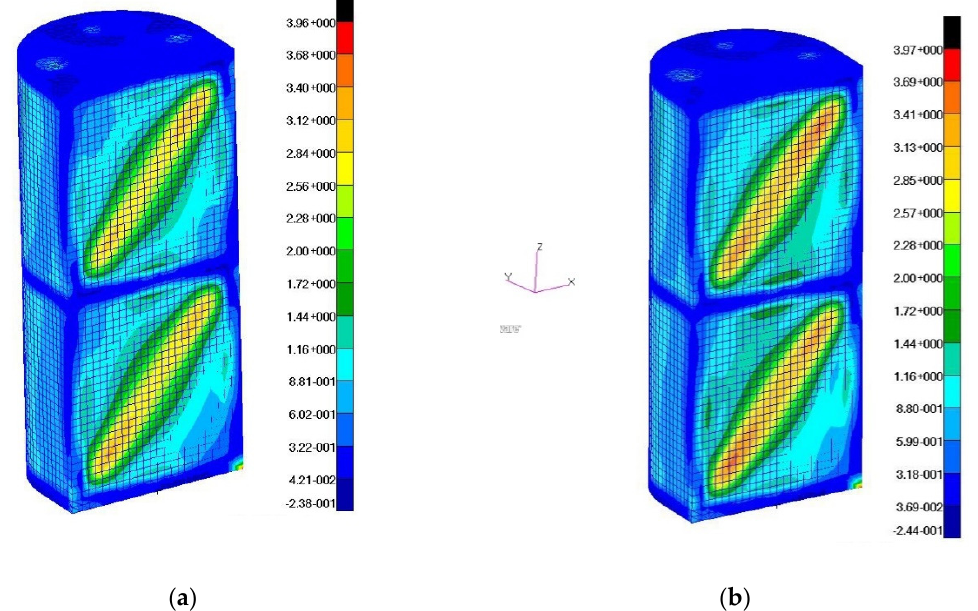
Figure 21. Distributions of reduced stress according to the σ max hypothesis: ( a ) a wall with the fiber orientation corresponding to the X, Z directions; ( b ) a wall with the fiber orientation at an angle of 45 degrees to the X, Z directions.